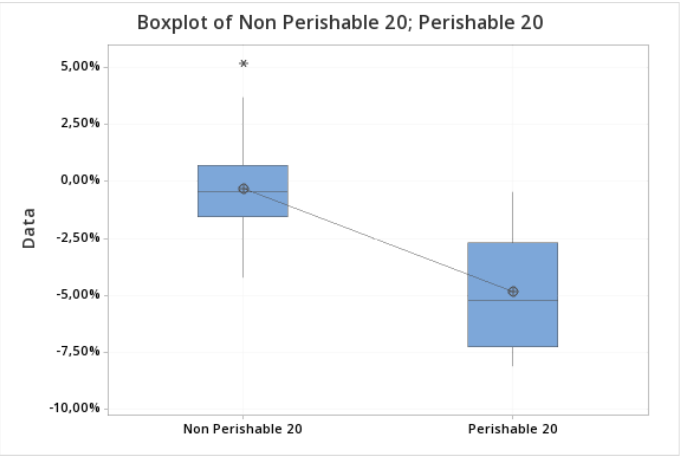
Figure 14. Boxplot CAARs event window E ( − 20,+20) .